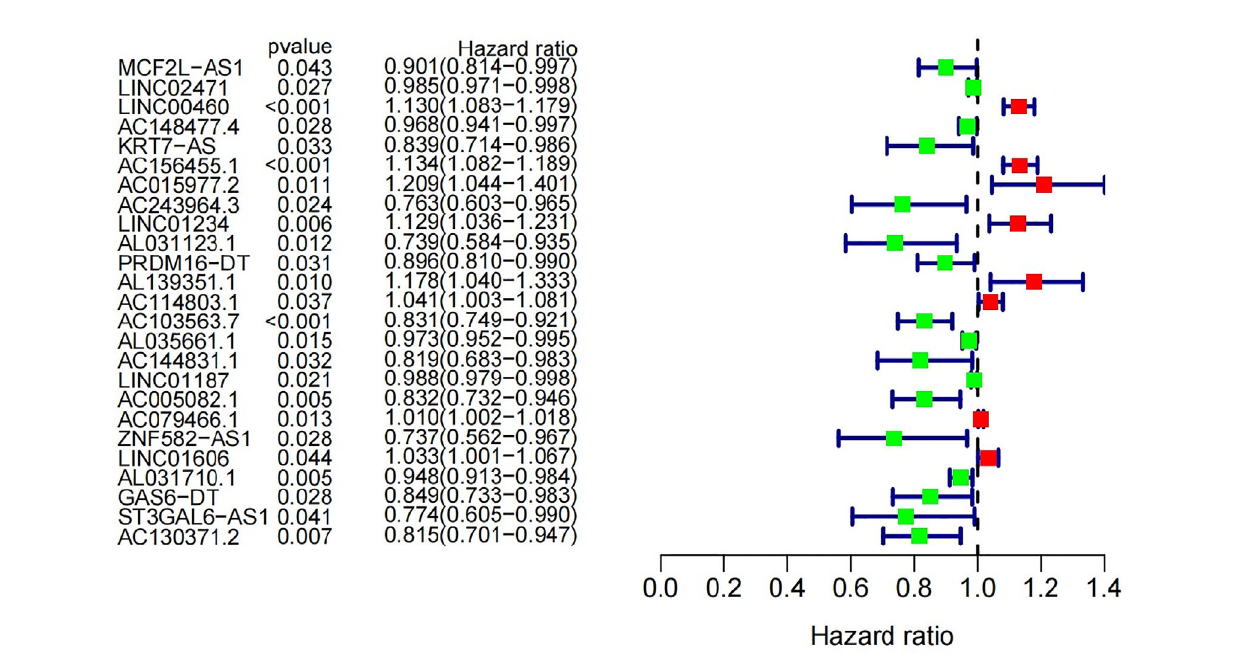
FIGURE 3 | Univariate Cox regression analysis was used in the Train set to construct forest plot of 25 GInLncRNAs associated with patients ’ overall survival. Eight GInLncRNAs were protecting factors for patients ’ survival (LINC00460, AC156455.1, AC015977.2, LINC01234, AL139351.1, AC114803.1, AC079466.1 and LINC01606), while the other seventeen GInLncRNAs were the risk factors for patients ’